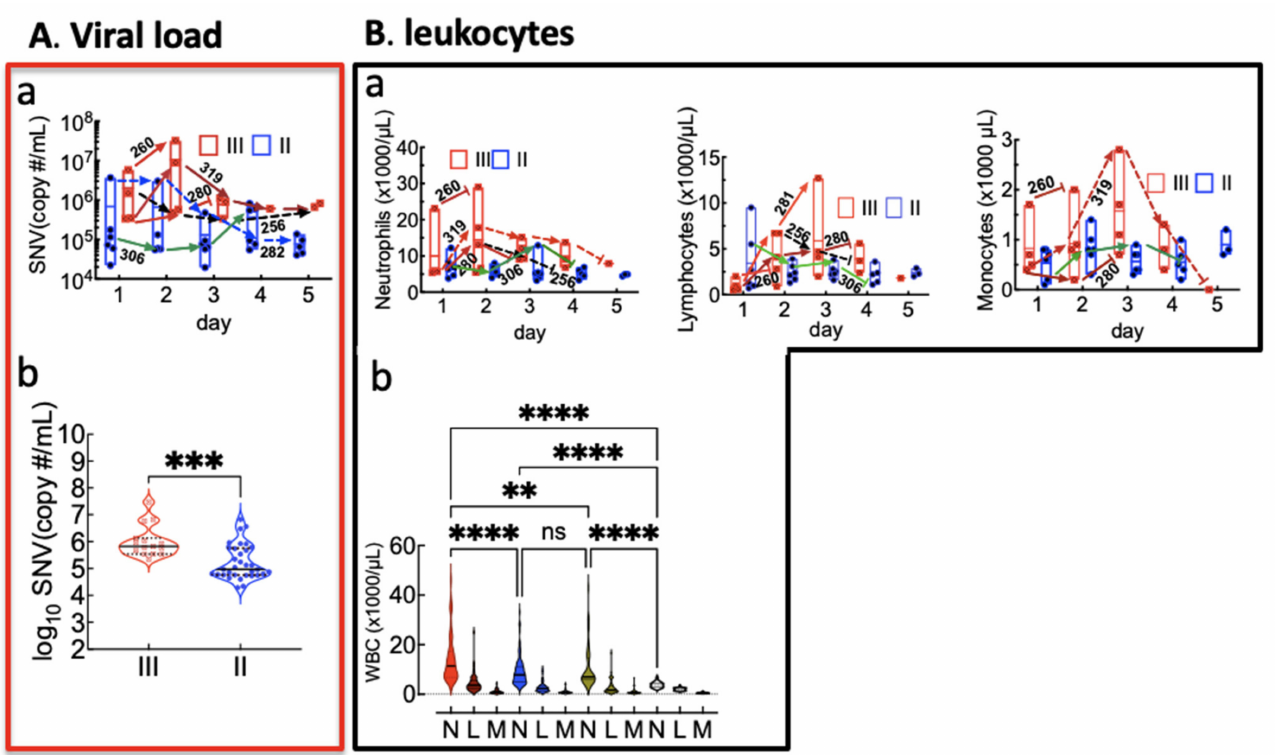
Figure 1. A ( a ) Top panel shows viral load in Class II and Class III patients measured in longitudinal plasma samples. Arrows are used to show the trajectory of select cases, that are discussed in the manuscript ( b ) The bottom panel shows a comparison of grouped mean viral load data of Class III and Class II cases using a paired t -test; *** p < 0.001; violin plots; solid lines, median; dotted lines, quartiles. B ( a ) The panel shows longitudinal expression of white blood cells (N), neutrophils (N), lymphocytes (L), and monocytes (M) for Class II (blue) and Class III (red) measured in this study. ( b ) The bottom panel shows retrospective chart review data of N, L, and M count, extracted from 15 Class I, 22 Class II, and 15 Class III HCPS cases. Each case comprised WBC data collected during the patient’s length of stay at UNMH. Levels of N, L, and M were compared by ordinary one-way ANOVA with Tukey’s correction for multiple comparison tests; ** p < 0.01, **** p < 0.0001. Only Class III N counts were significantly different from Class II, I, and